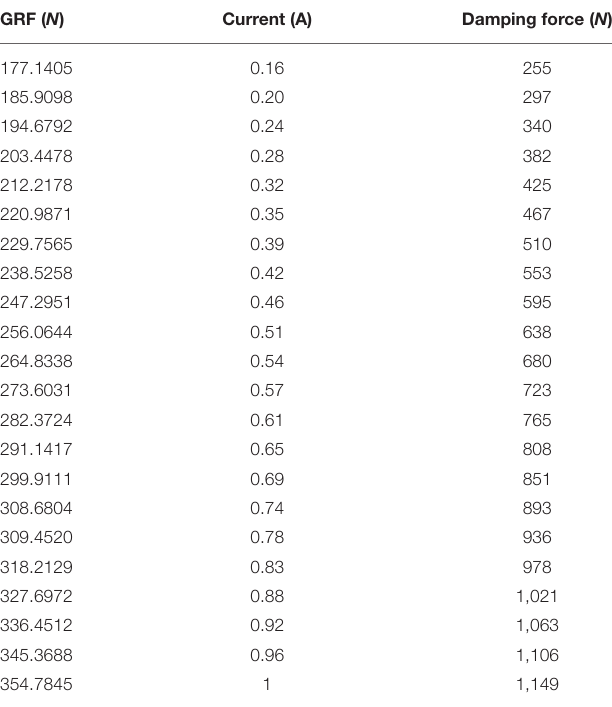
TABLE 1 | Relation between GRF, current, and damping